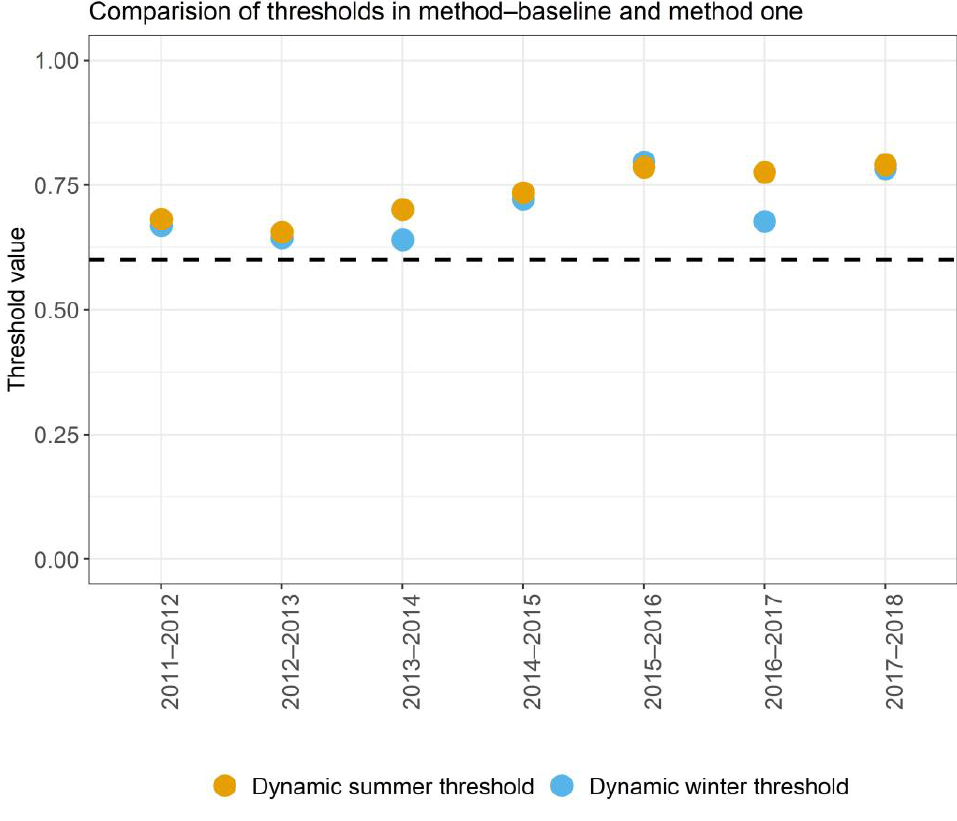
Figure 9. The comparison of the threshold (MAX) used in method—baseline and method one . The black, dashed line indicates the fixed value of the MAX (0.6) used in method—baseline .